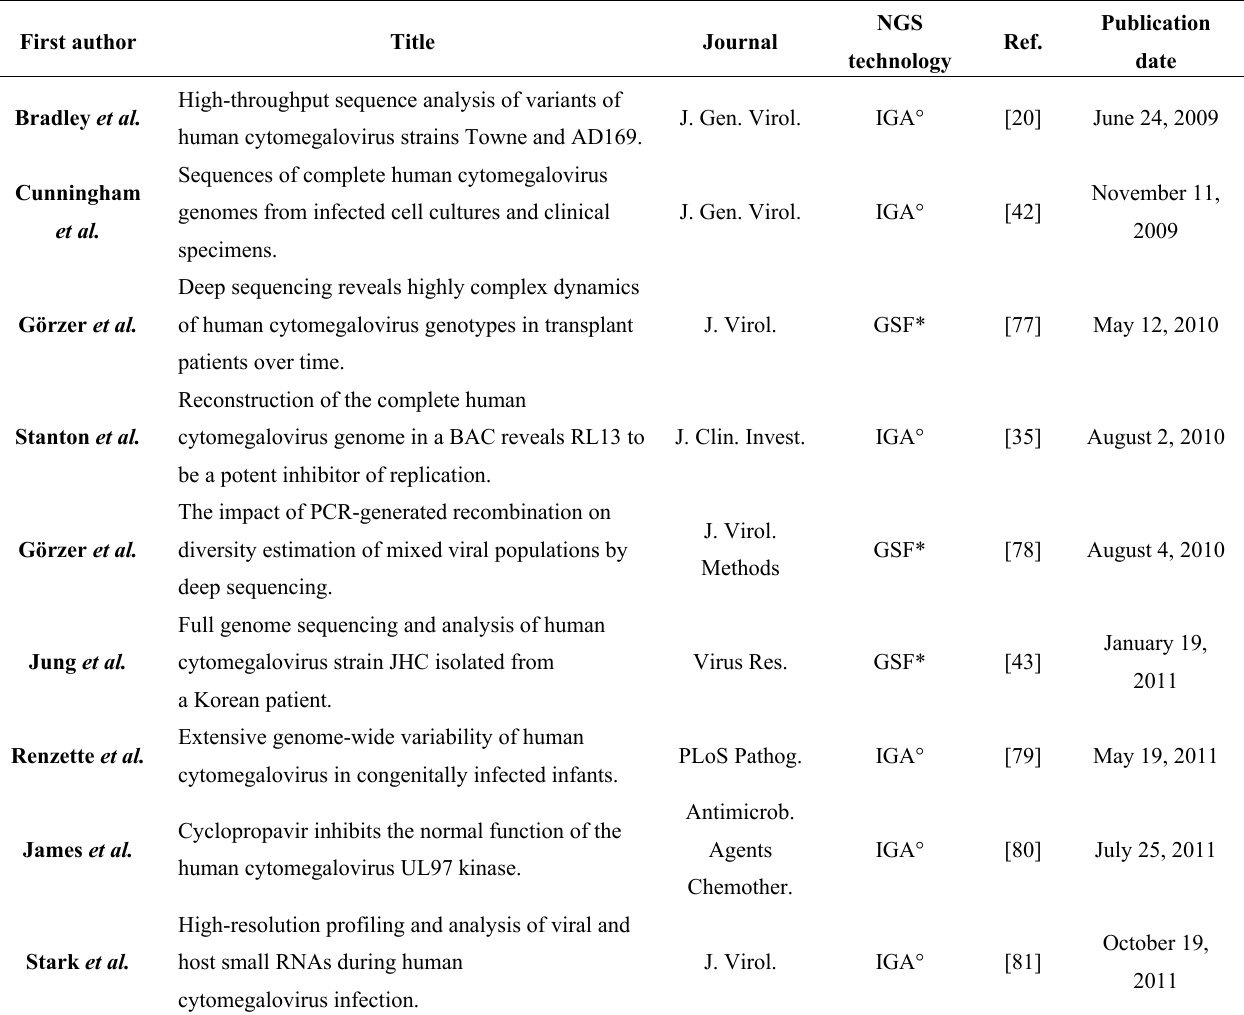
Table 2. Overview of studies on the HCMV genome making use of NGS technology, ranked in chronological